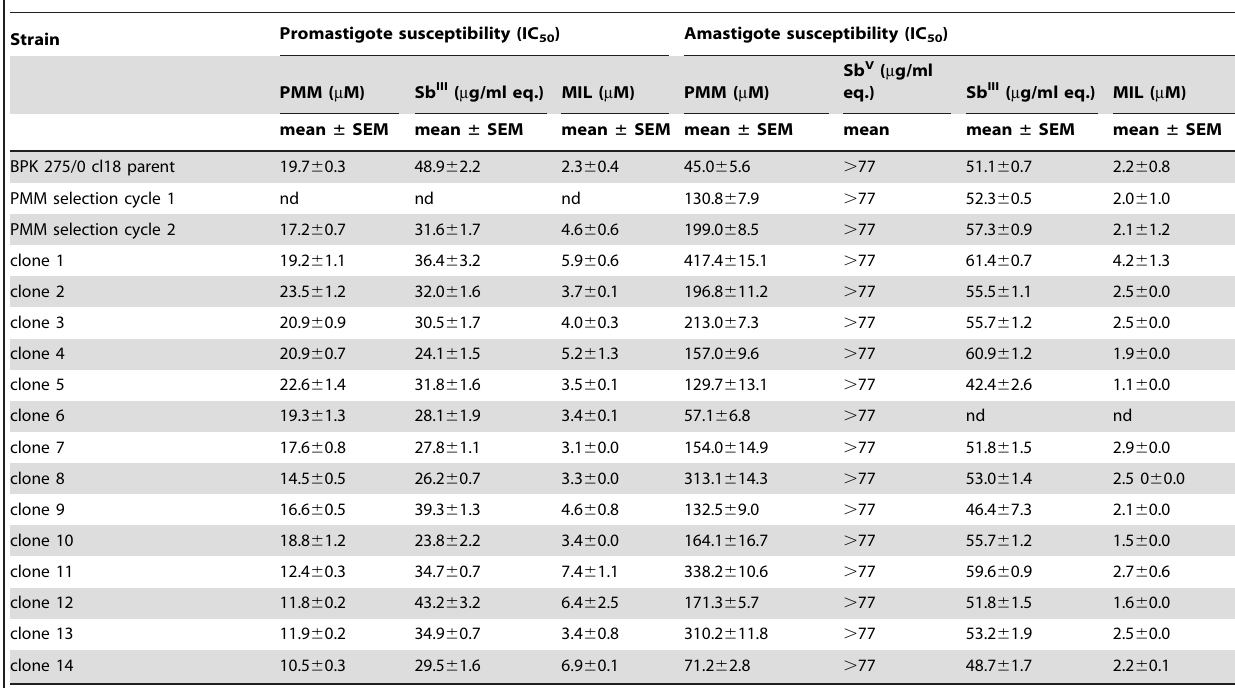
Intracellular amastigotes were transformed back to the extracellular (without drug exposure) promastigote stage after each selection cycle. After selection cycle-2, fourteen clones were obtained from the induced PMM-resistant promastigote